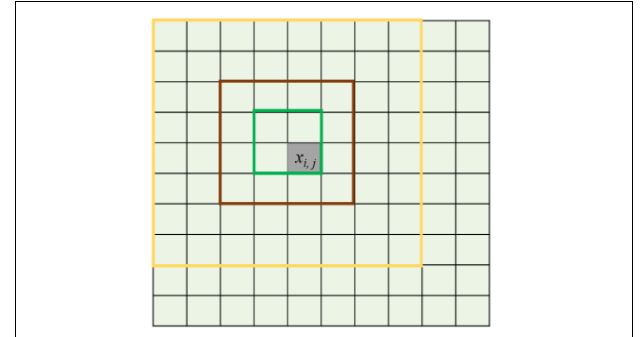
FIGURE 4 | Multi-scale image description of the different pixel neighborhood